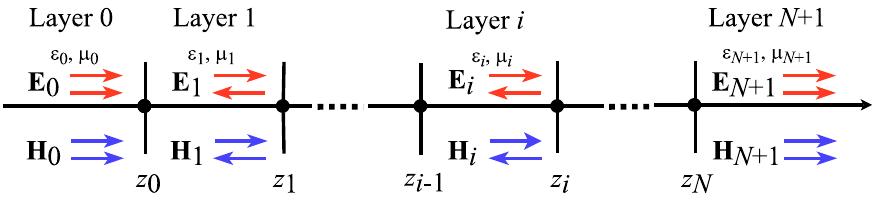
Figure 3. One-dimensional model of a layered structure.